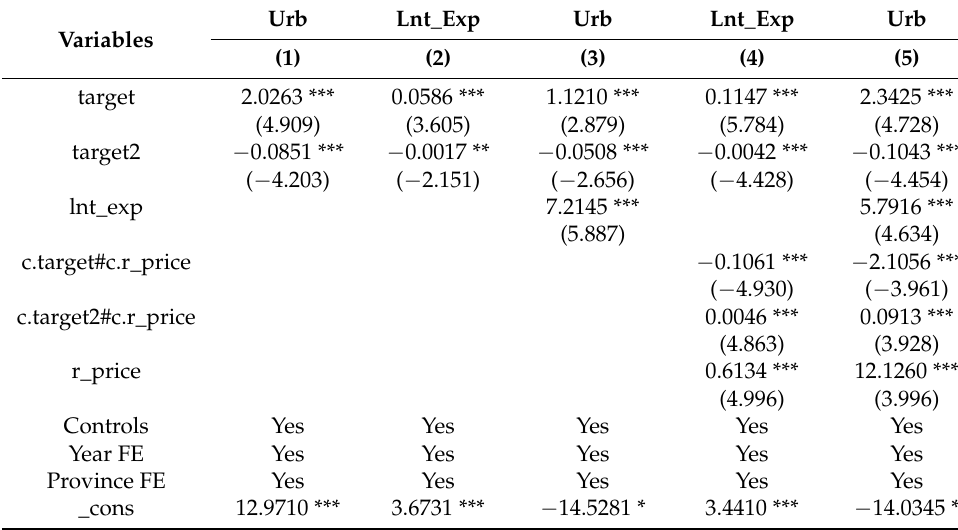
Table 9. Regression with a single indicator as the dependent